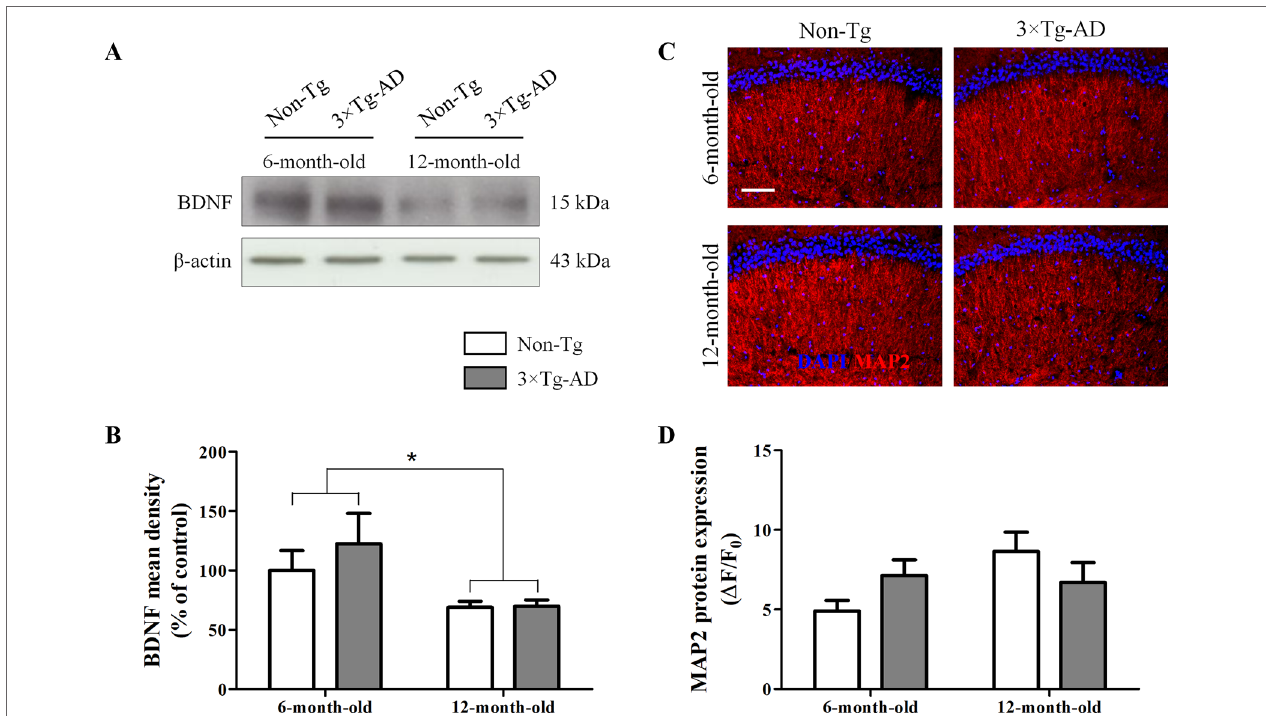
FIGURE 3 | Effects of aging on BDNF and MAP2 expression in hippocampus of 3×Tg-AD and Non-Tg mice. (A) Representative Western blots for BDNF and (B) densitometric analysis normalized to β -actin as loading control. Results are expressed as means ± SEM of percentage of controls (6-month-old/Non-Tg) (N = 3, in triplicate). (C) Representative fluorescent photomicrographs of MAP2 (red) in the hippocampal CA1 region of both 6- and 12-month-old Non-Tg and 3×Tg-AD mice. (D) MAP2 fluorescence analysis is expressed as ΔF/F 0 = [(F− F 0 )/F 0 ], where F is the mean fluorescence intensity and F 0 is the mean background fluorescence. Nuclei were stained with DAPI (blue). Scale bar 50 µm. Statistical analysis was performed by two-way ANOVA followed by Bonferroni’s post hoc test (* p < 0.05; 6-month- old vs